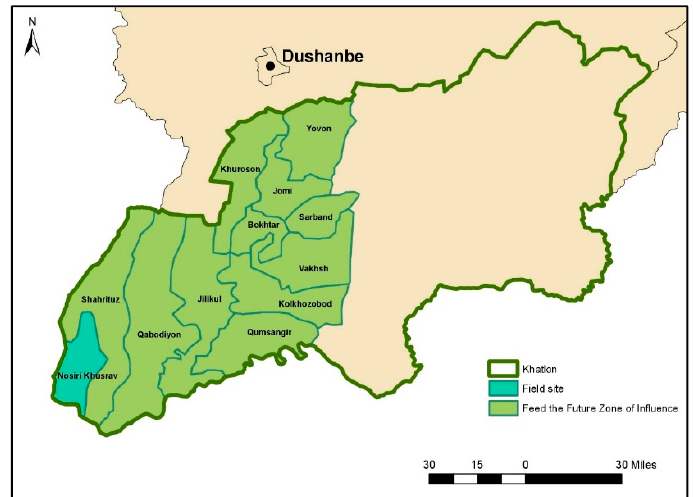
Figure 3. Districts of Khatlon Province, Tajikistan.